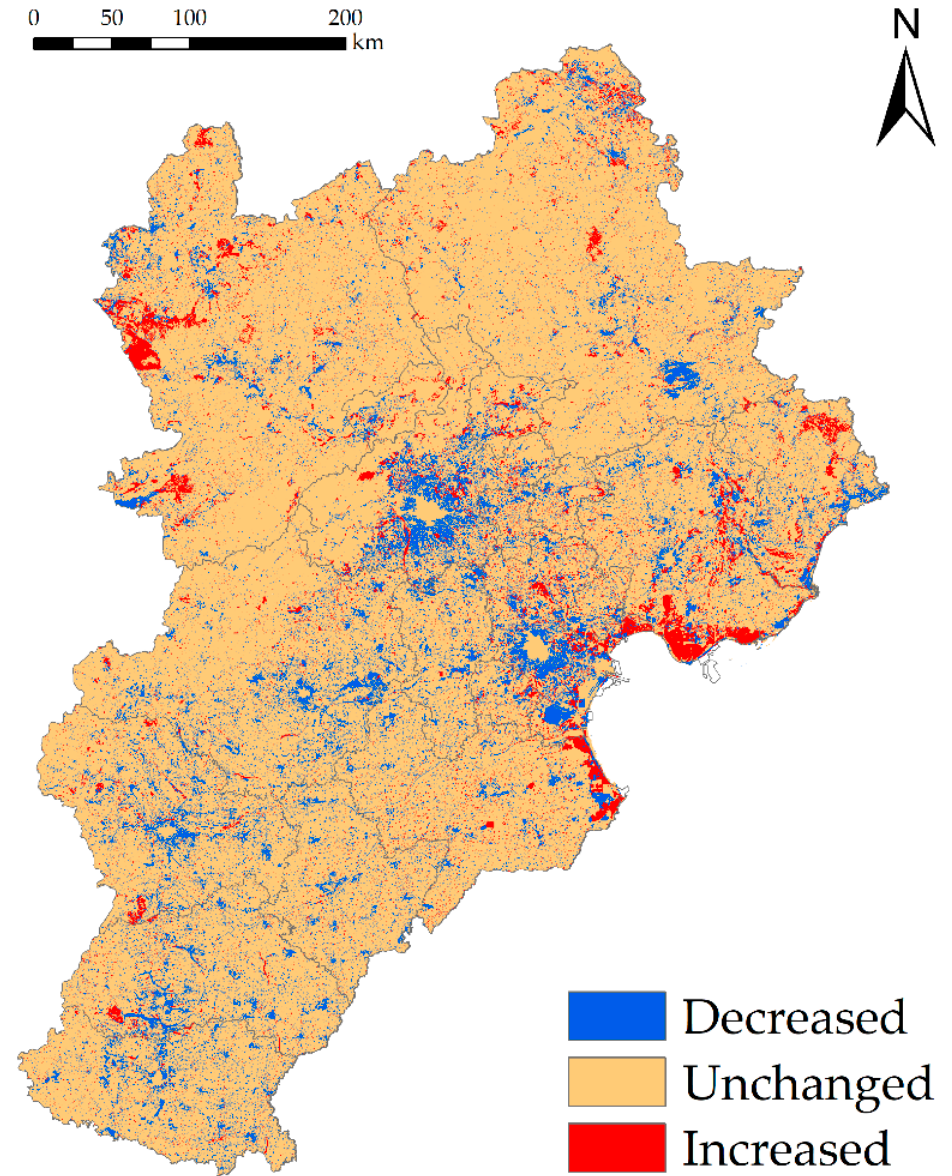
Figure 6. The spatial variation of carbon storage from 1990 to 2020.